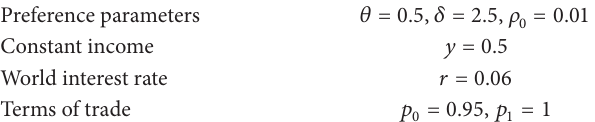
Table 1: The data in empirical analysis. Preference parameters